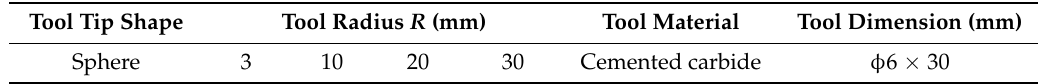
Table2. Processing condition. Table 2. Processing